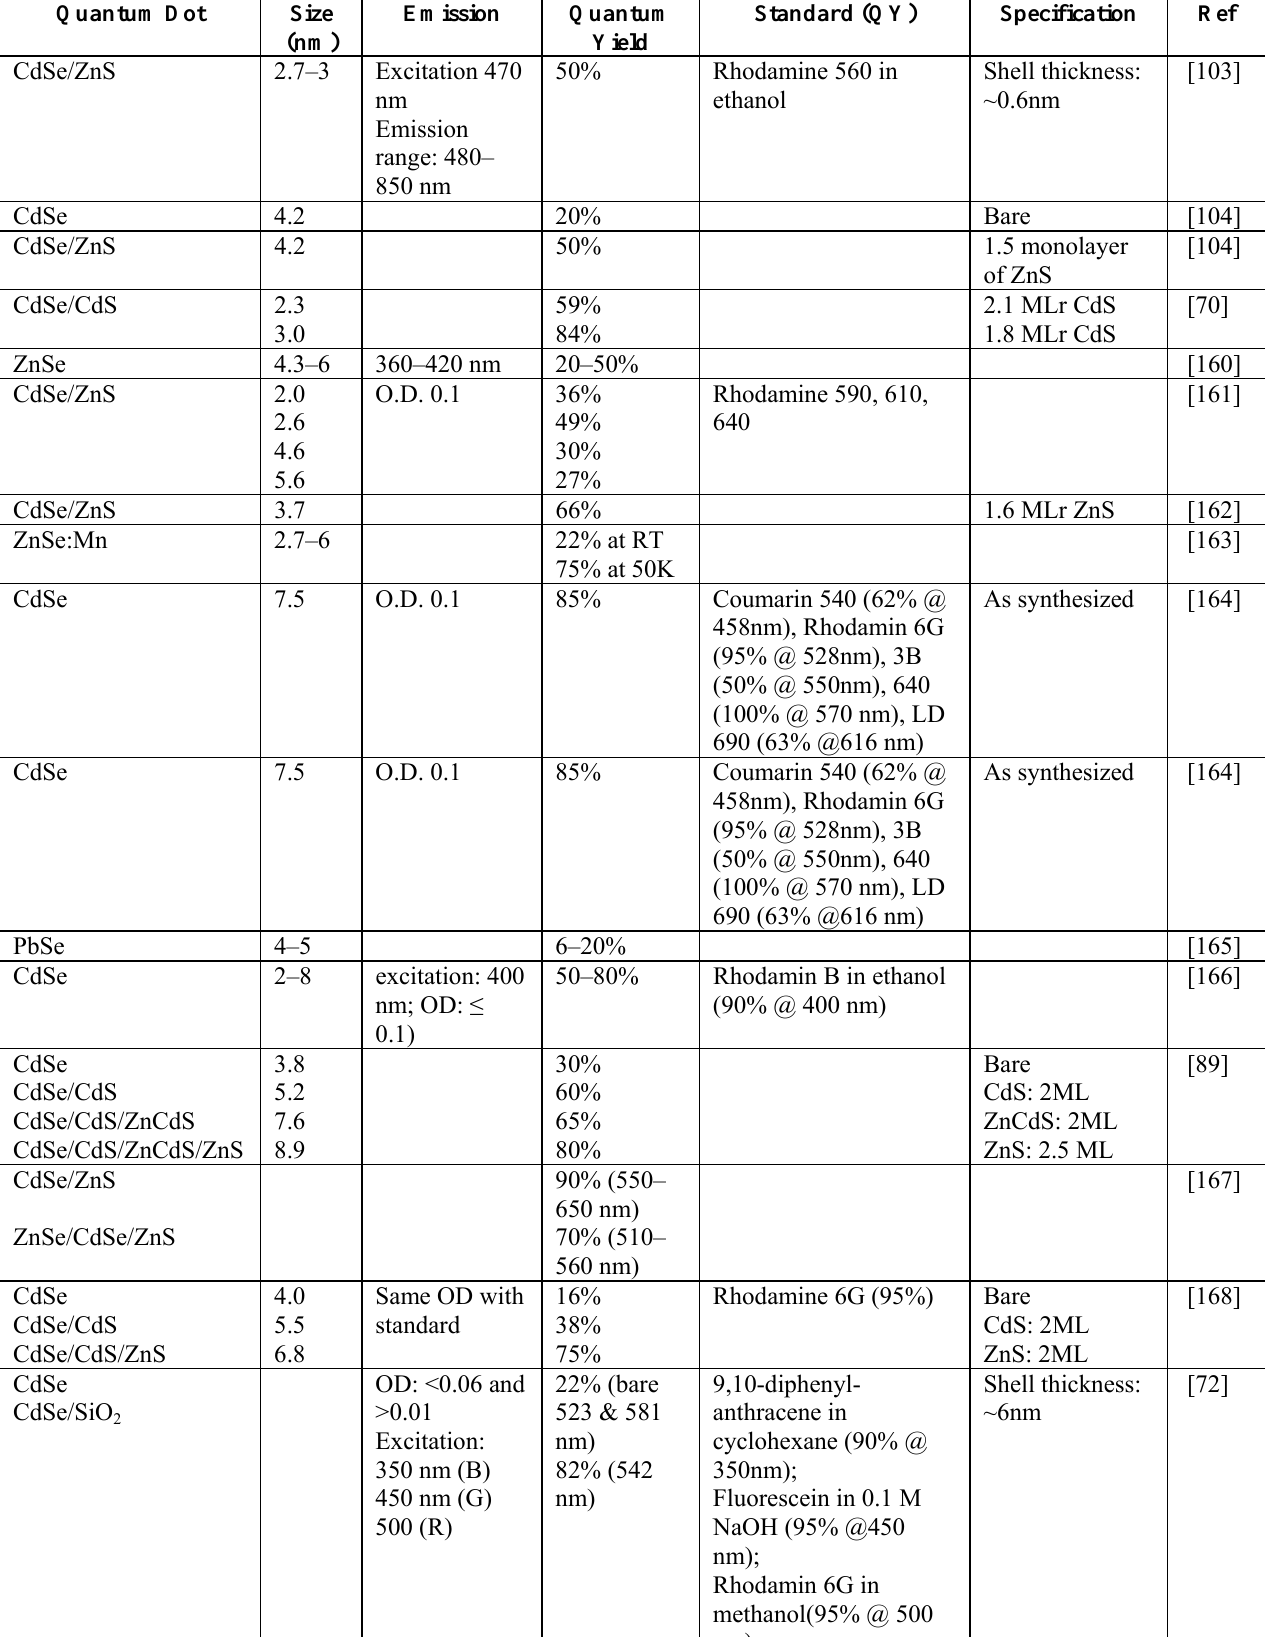
Table 2. Some of the literature reported Qdot Quantum Yield data for selected systems. Quantum